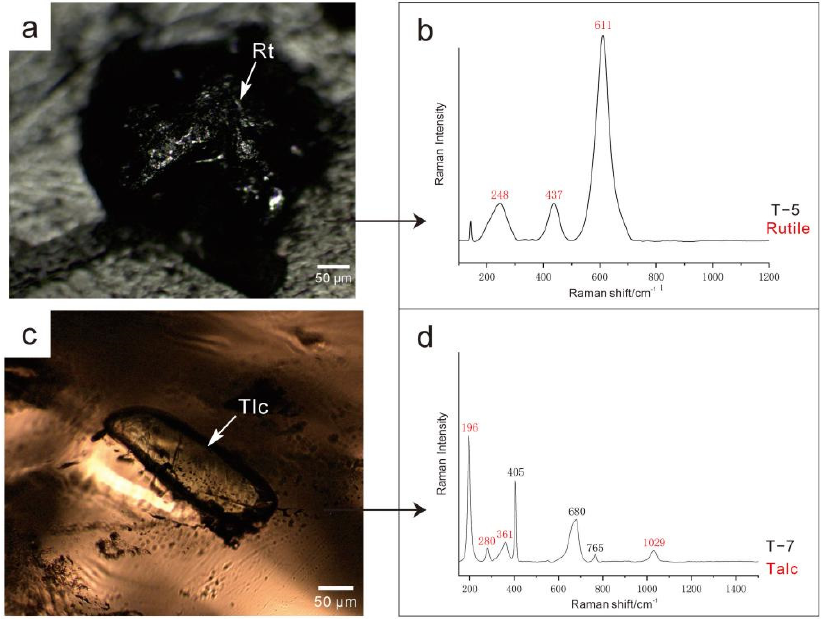
Figure 11. ( a ) Rutile inclusion in Tajikistani spinel (T − 5) and ( b ) its (T − 5) Raman spectrum. ( c ) Talc inclusion in Tajikistani spinel (T − 7) and ( d ) its (T − 7) Raman spectrum.